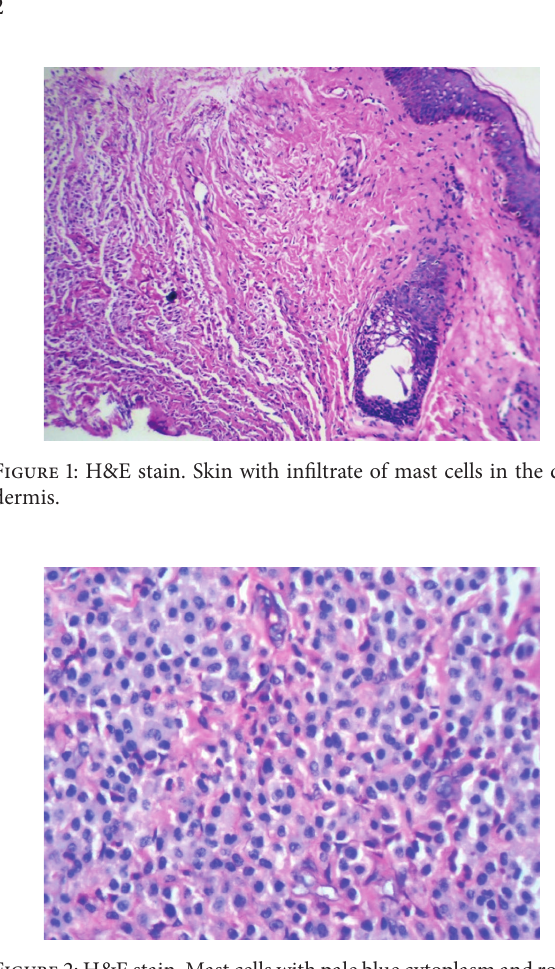
Figure 2: H&E stain. Mast cells with pale blue cytoplasm and round to oval nuclei.